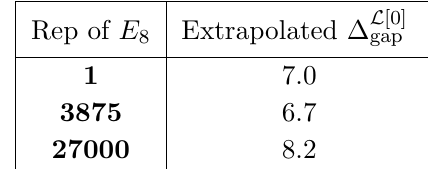
Table 4 . The estimated gaps in the scaling dimensions of long multiplets transforming in the 1